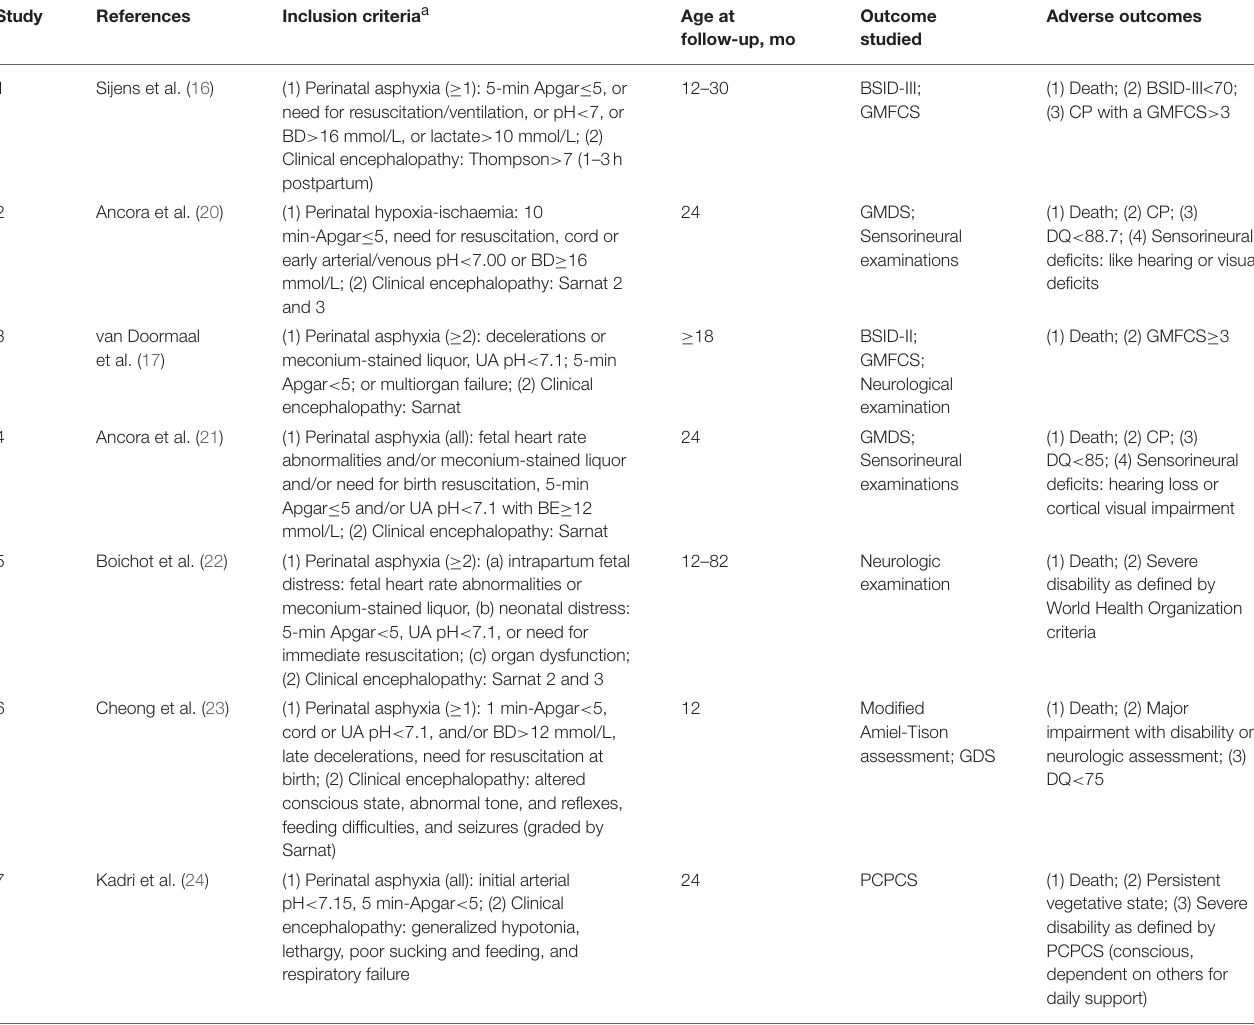
TABLE 2 | Study inclusion criteria and outcome measures.